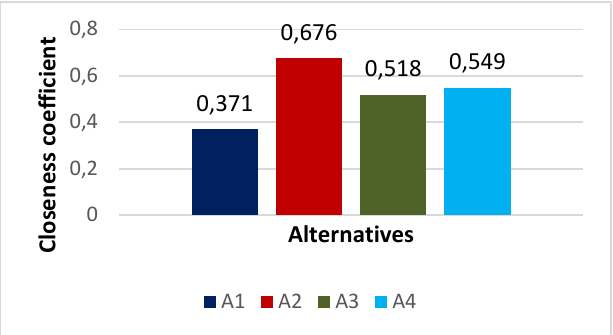
Figure 4. Closeness coefficient graph